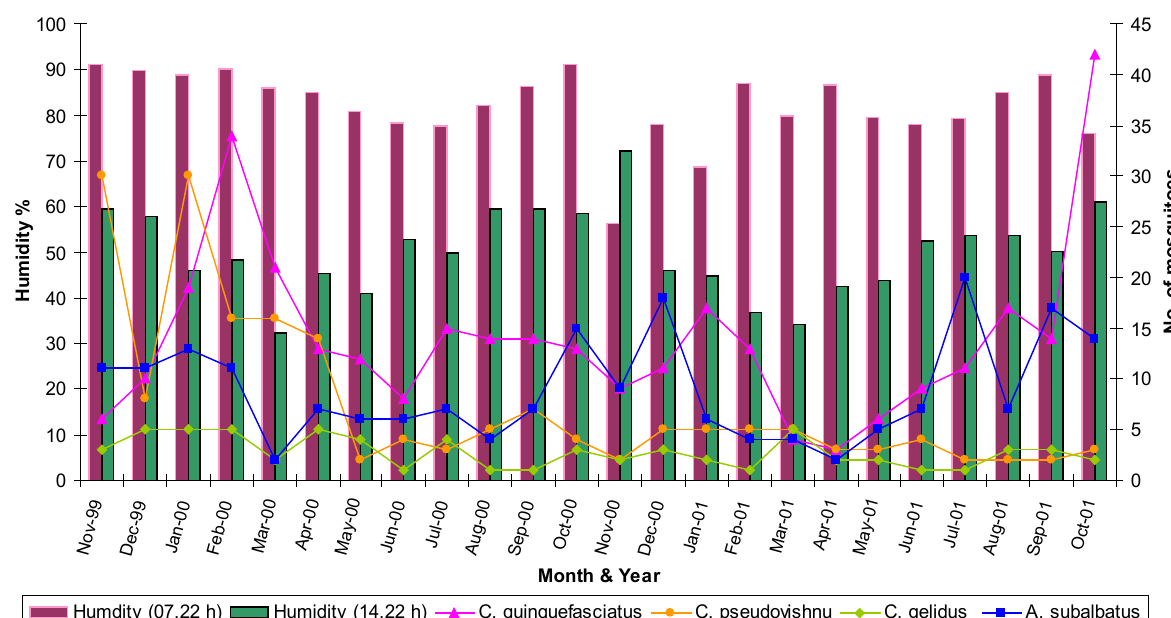
Figure 2. Population dynamics of mosquito species in relation to humidity (0722 & 1422 hr) in North Coimbatore POPULATION DYNAMICS OF MOSQUITO SPECIES IN RELATION TO HUMIDITY IN NORTH COIMBATORE